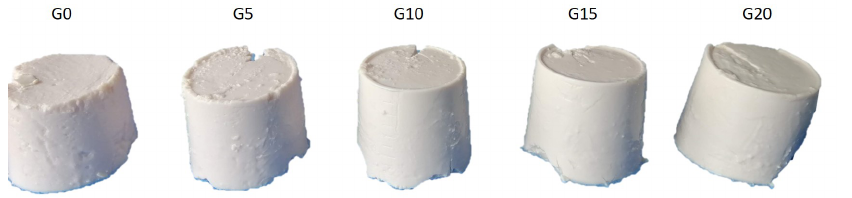
Figure 4. Fermentation-induced PPI gels with 10% protein after 7 days of storage under refrigeration in closed containers. Sample name corresponds to its oil content, e.g., G0: 0% oil, G5: 5% oil,